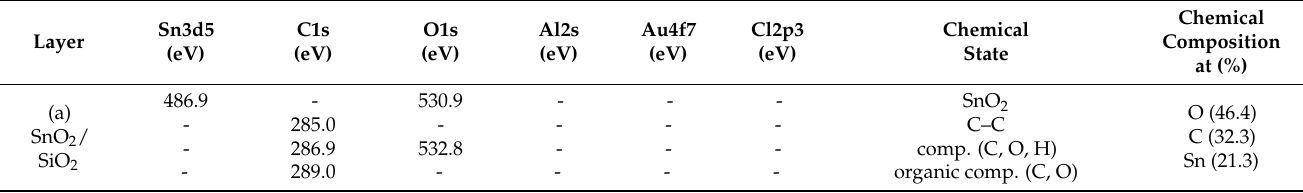
Chemical Chemical Composition State at